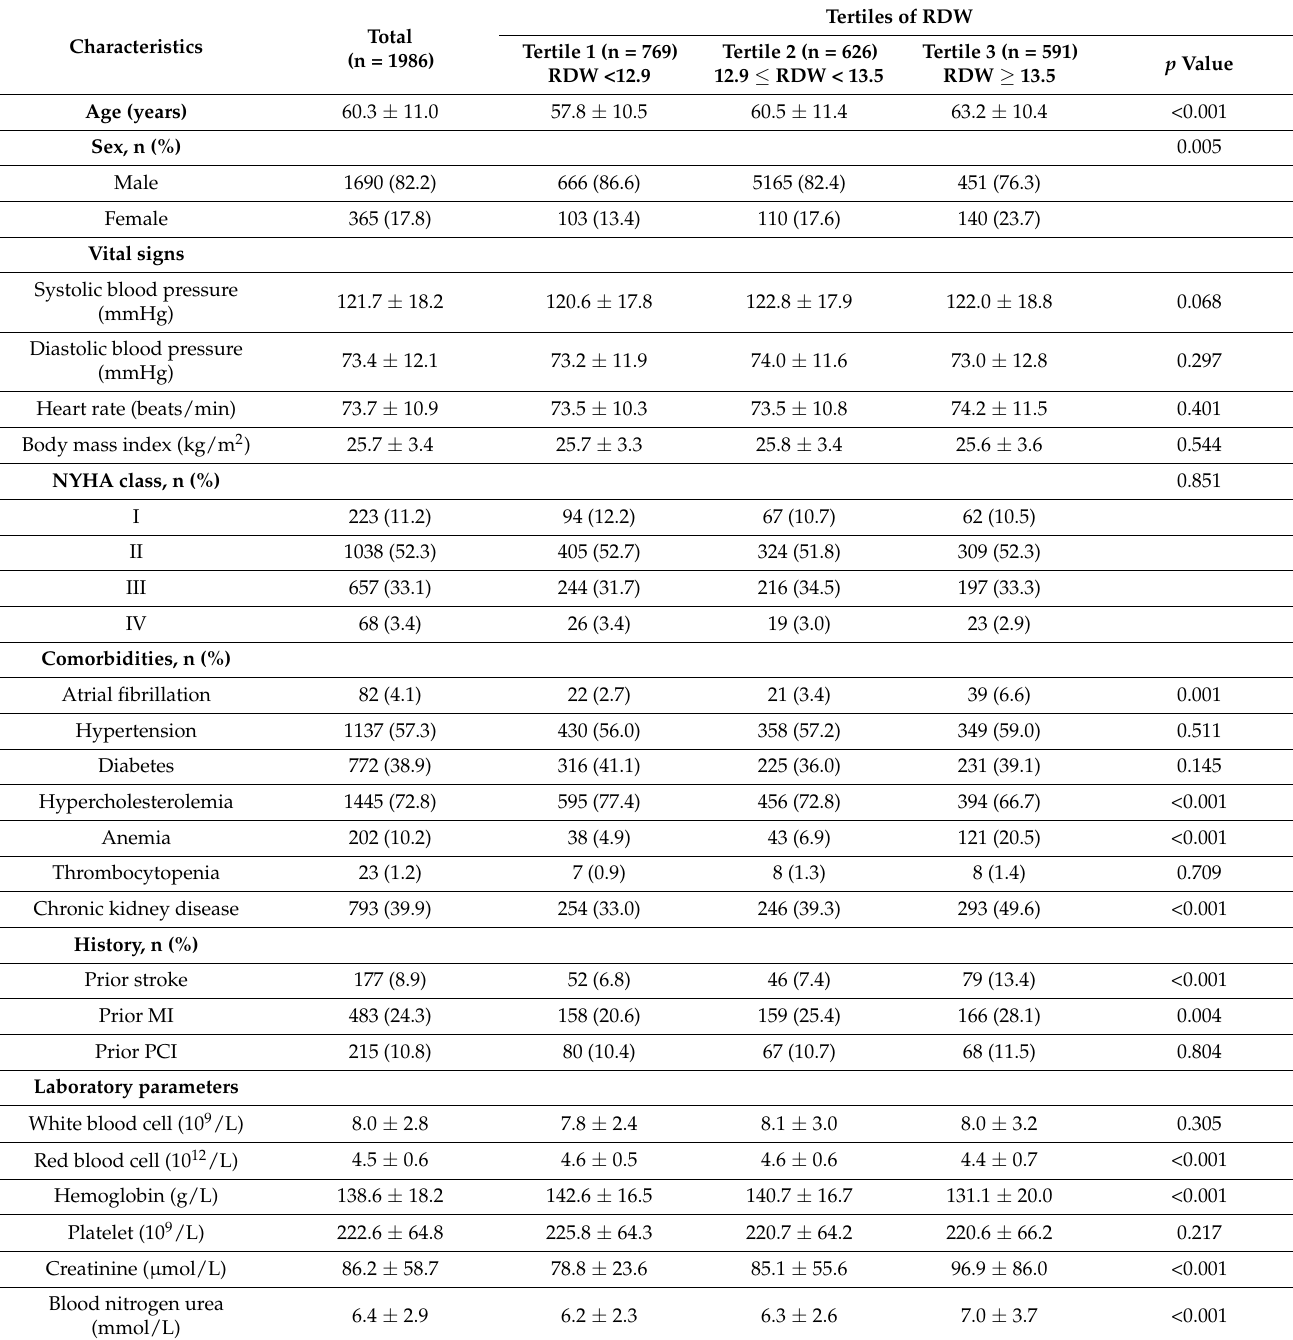
Table 1. Characteristics of patients stratified by RDW